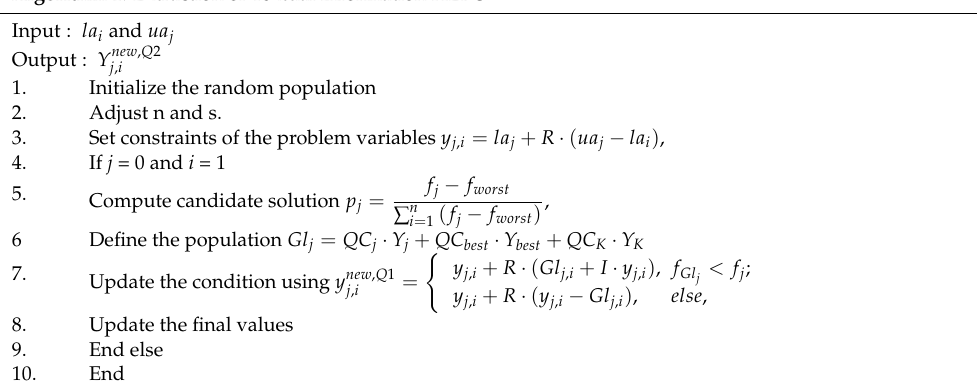
Algorithm 1. Extraction of Textual Information